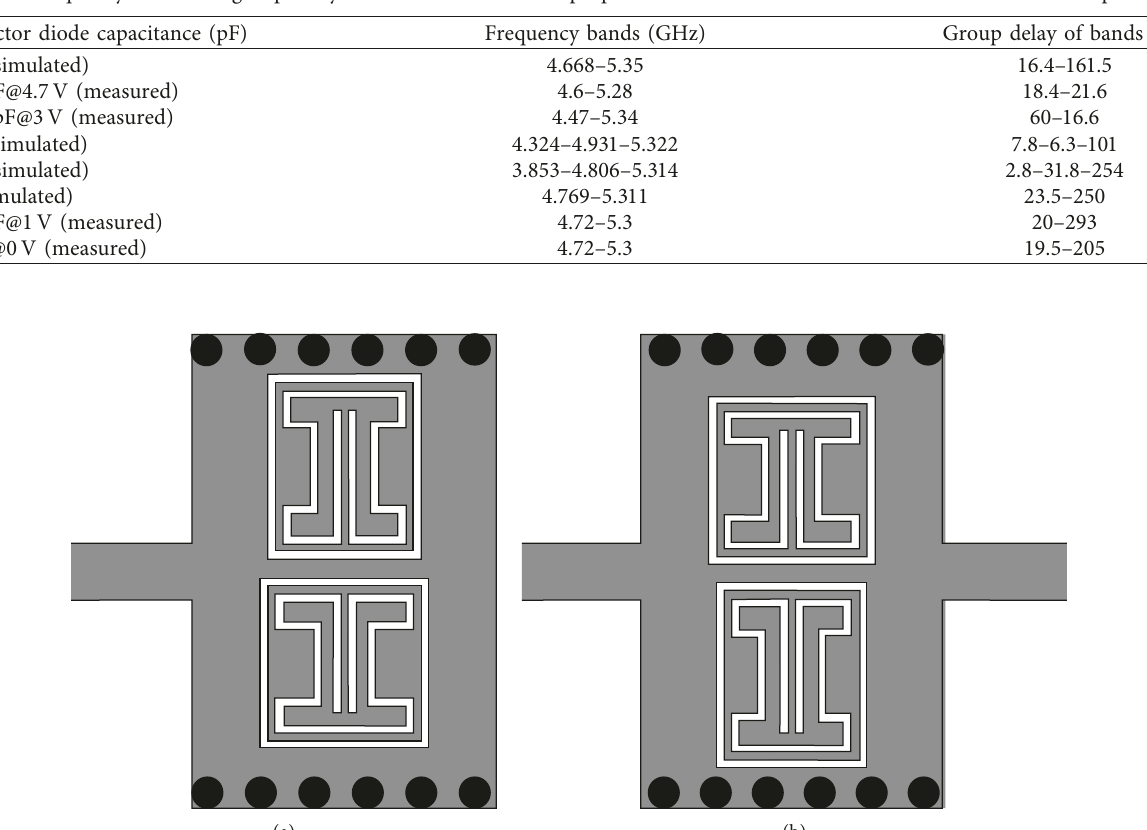
Figure 11: Configuration of the third proposed resonator using proposed base layout: (a) singly loaded resonator (one port) and (b) doubly loaded resonator (two ports).